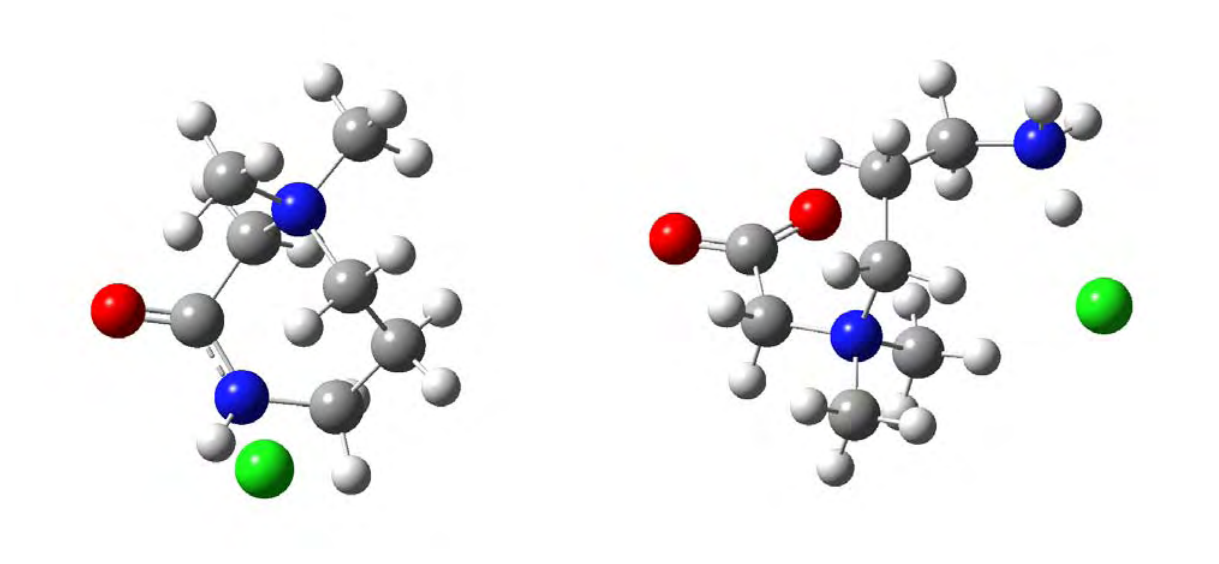
Figure.1 . Structures of a) 1,1-dimethyl-3-oxo-1,4-diazepan-1-ium chloride ( 1 ) and b) 1,1-dimethyl-1-carboxymethyl-3-aminopropyl ammonium hydrochloride ( 2 )